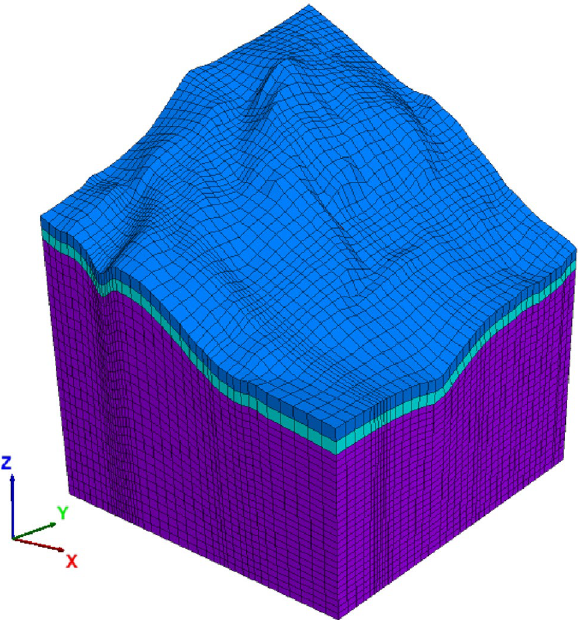
Figure 4. 3D model of the mountain where the Shuangjiangkou hydropower station located.